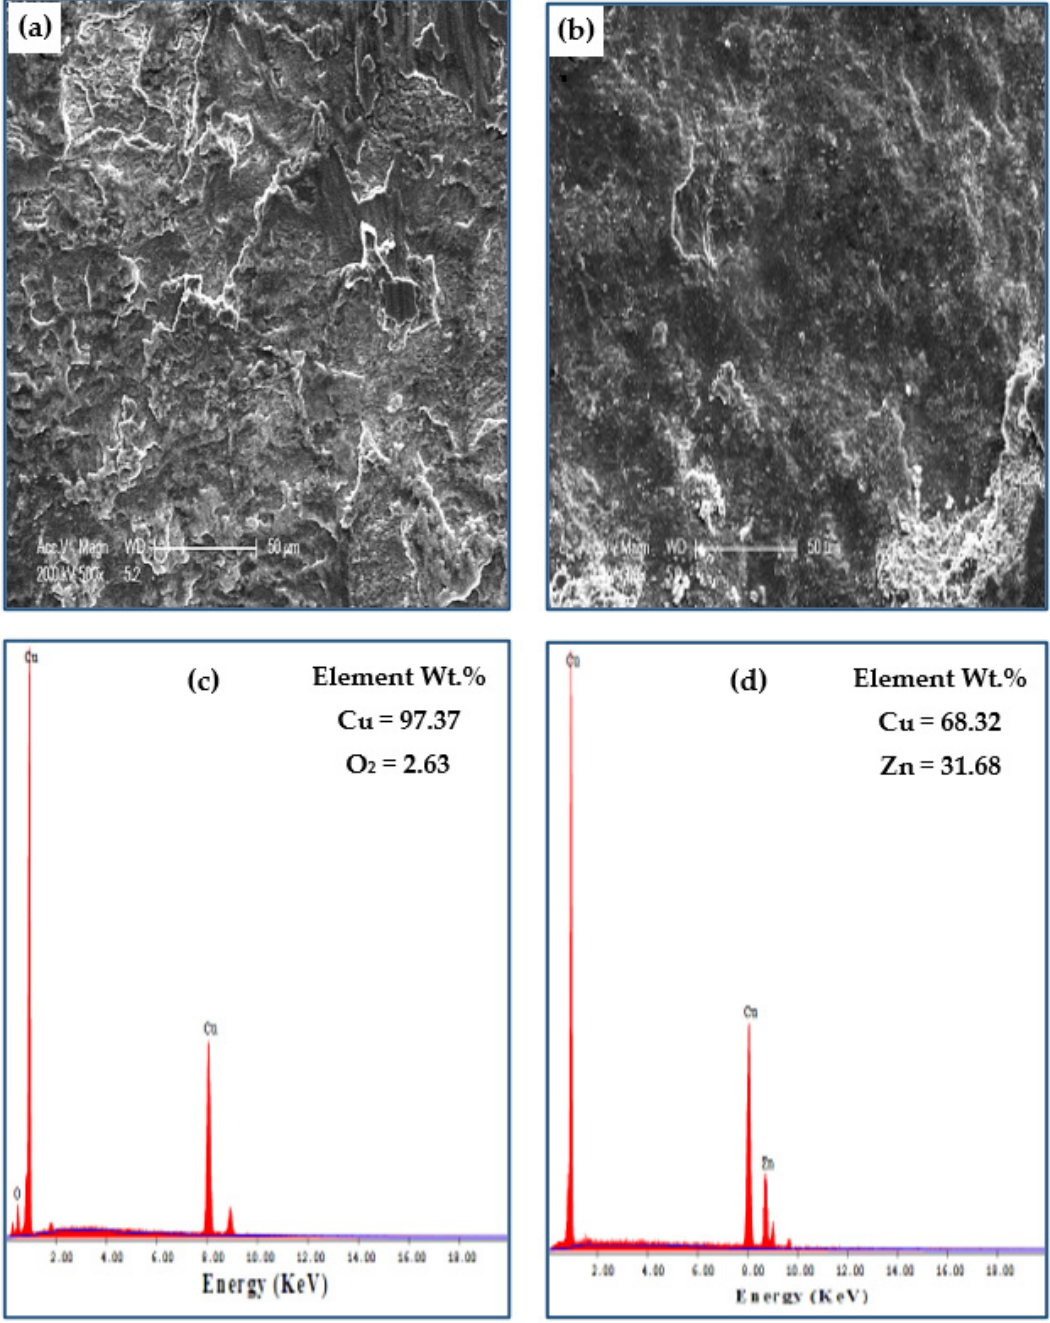
Figure 14. Worn surface morphology and EDS, analysis ( a – c ) of the Cu tube after 4 passes and ( b – d ) of the brass tube after 2 passes, under a sliding distance of 2062.8 m and an applied load of 50 N.